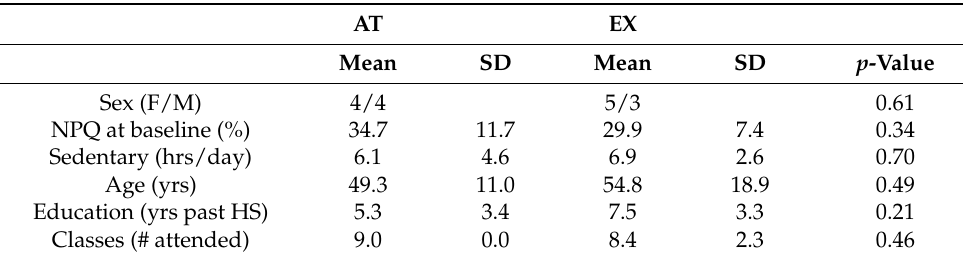
Classes (# attended) 9.0 AT = Alexander technique. EX =